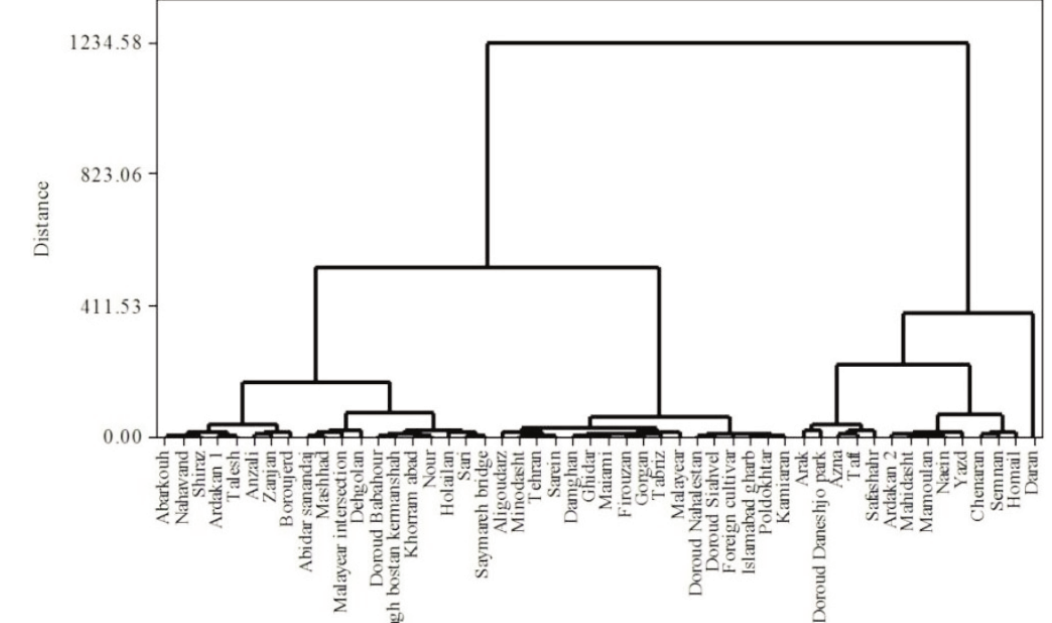
Fig. 3 - Dendrogram of the physiological relationships between 50 accessions of common bermudagrass and control cultivar aftrer cold stress at 7.5/0°C day/night